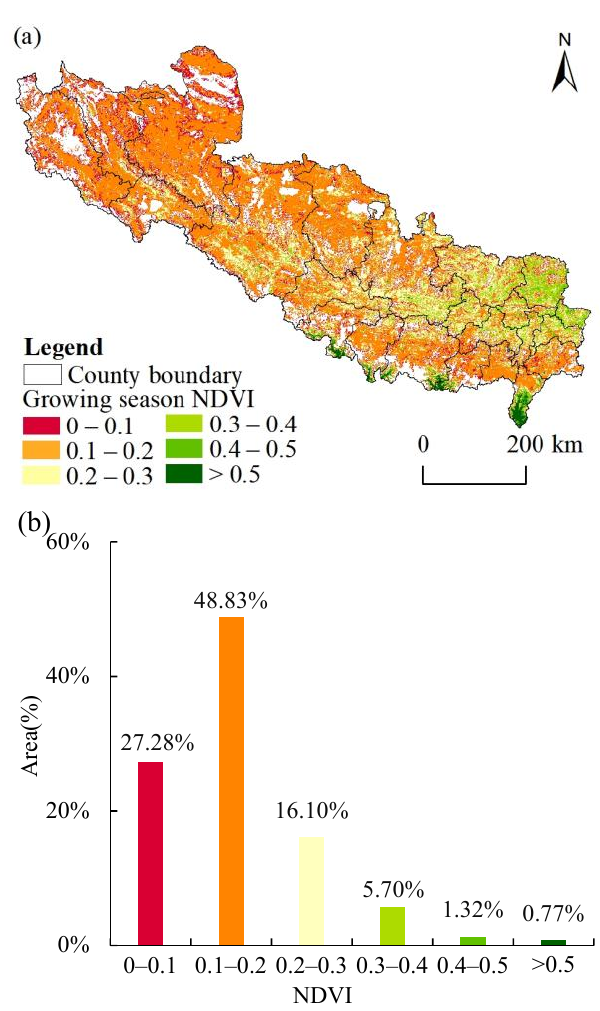
Figure 2. The spatial distribution of the NDVI ( a ) and areal proportion ( b ) in the average growing season from 2000 to 2020.